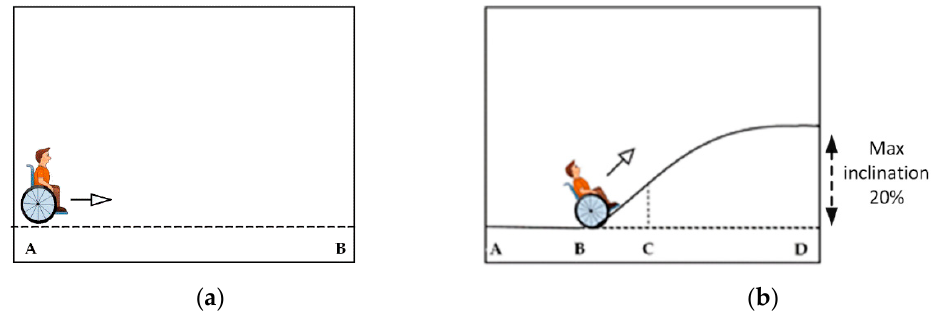
Figure 4. The logic for the smart energy management system (SEMS): ( a ) normal plaint track-AB; ( b ) uphill climbing steep track-ABCD.